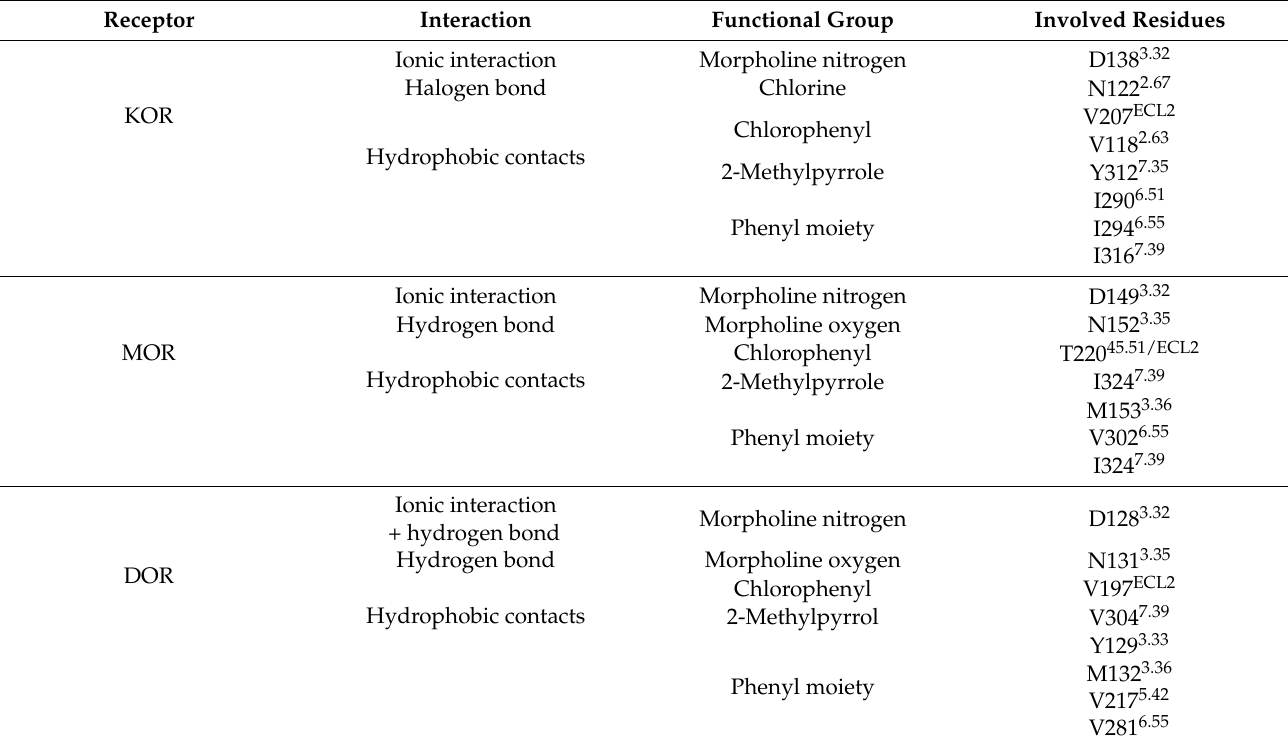
Table 2. Protein–ligand interactions between Compound A and the opioid receptors, KOR, MOR and DOR, derived from docking